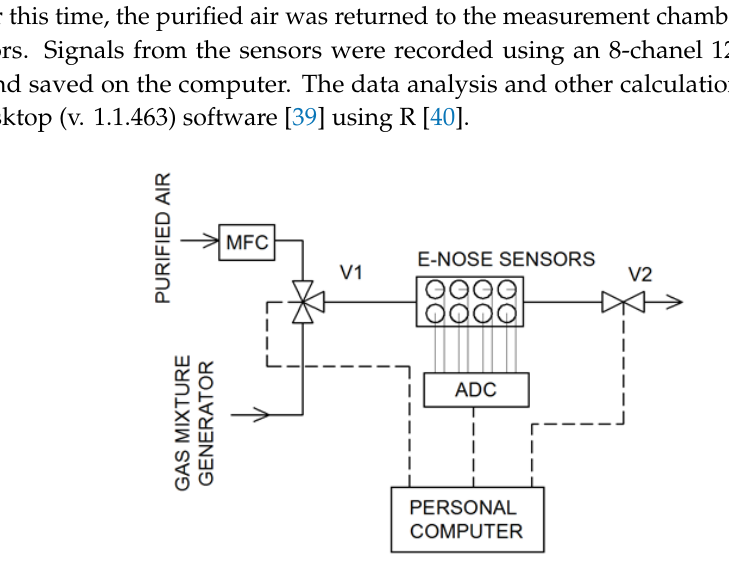
Figure 2. Electronic nose experimental setup (MFC — mass flow controller, ADC — analog-to-digital converter). Figure 2.